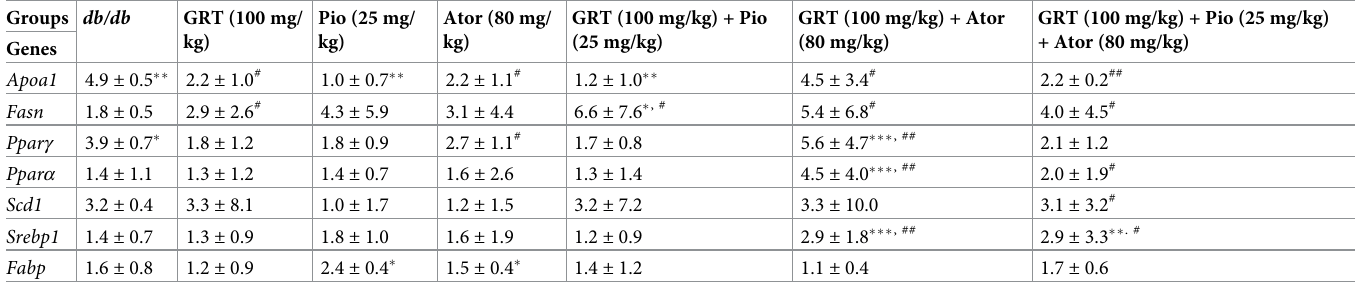
Table 3. Summary of liver gene expression in db/db mice. Groups